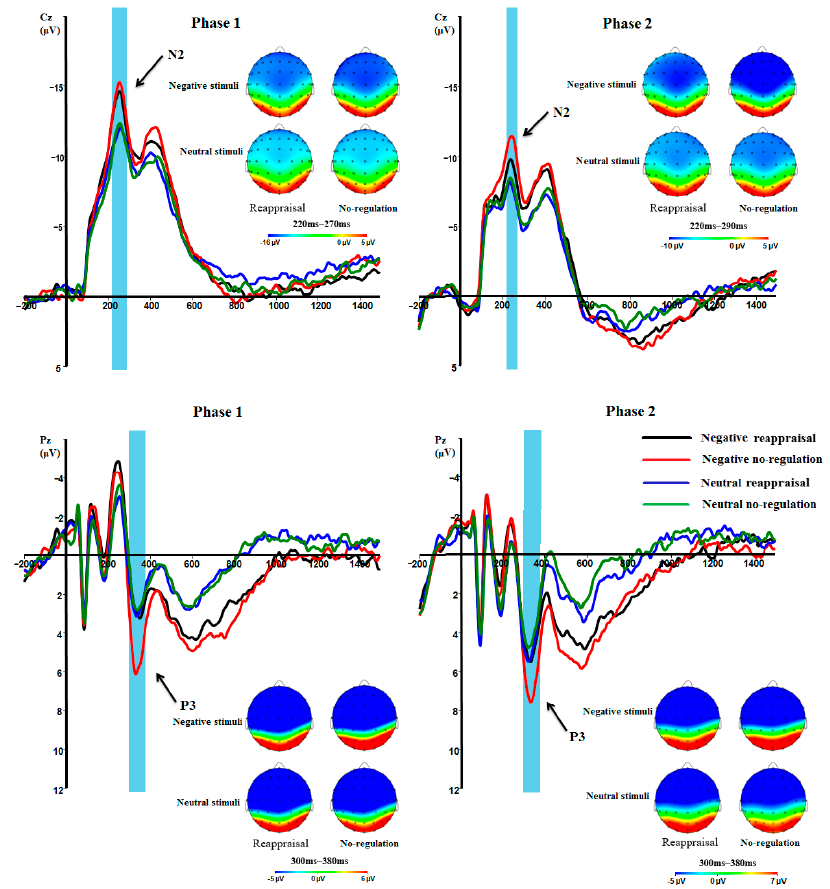
Figure 3. Stimulus-locked grand averaged waveforms and scalp distributions of mean activity between different conditions in Cz and Pz.